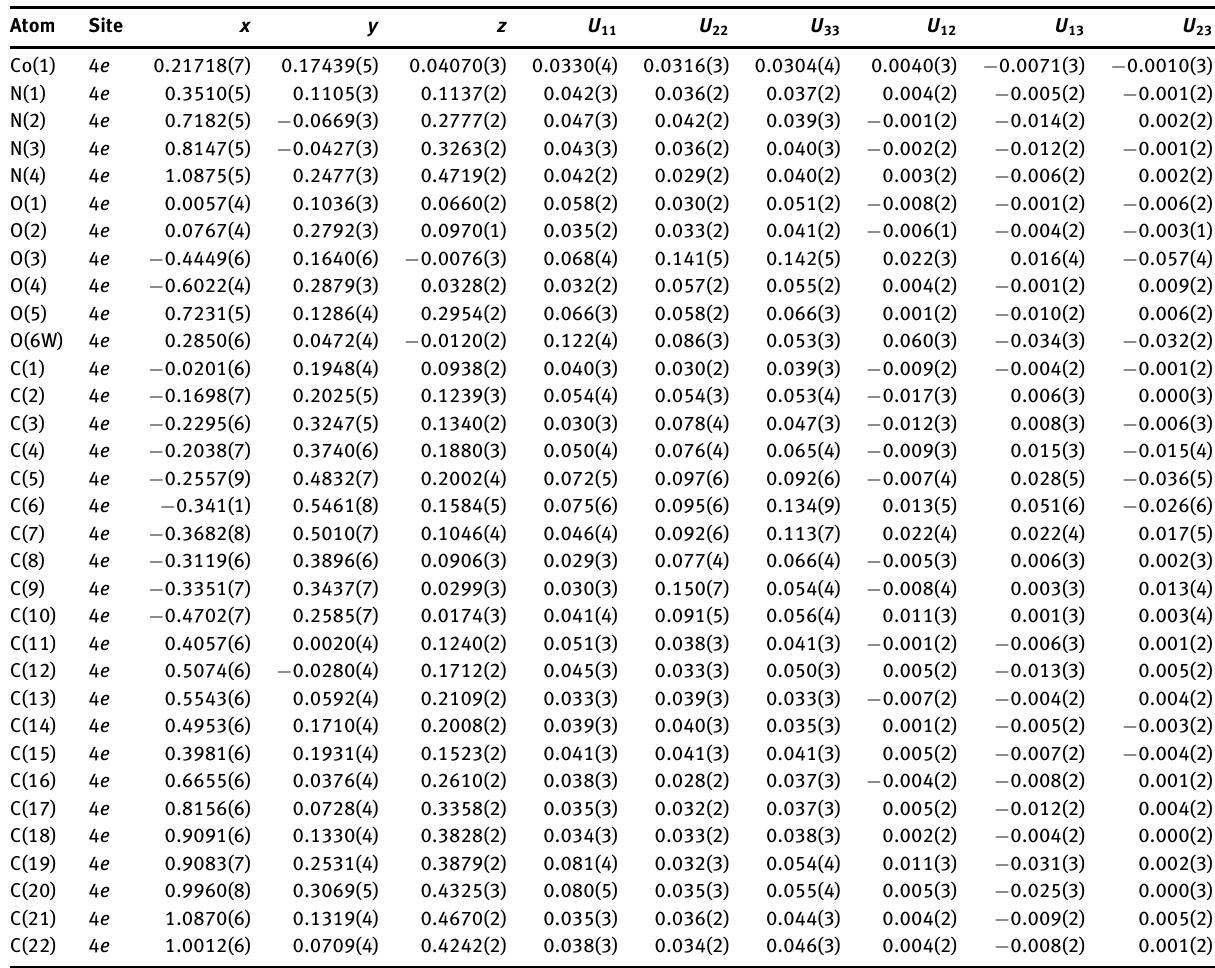
Table 3: Fractional coordinates and atomic displacement parameters (Å 2